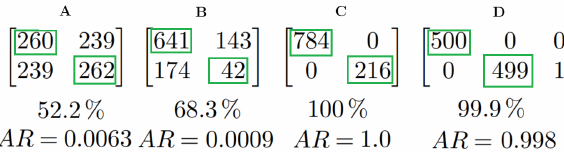
Figure 4. Four example matching matrices. Immediately below each matrix is the percentage of particles placed into the same clus- ter for both clusterings in each case. At the very bottom we have the adjusted rand